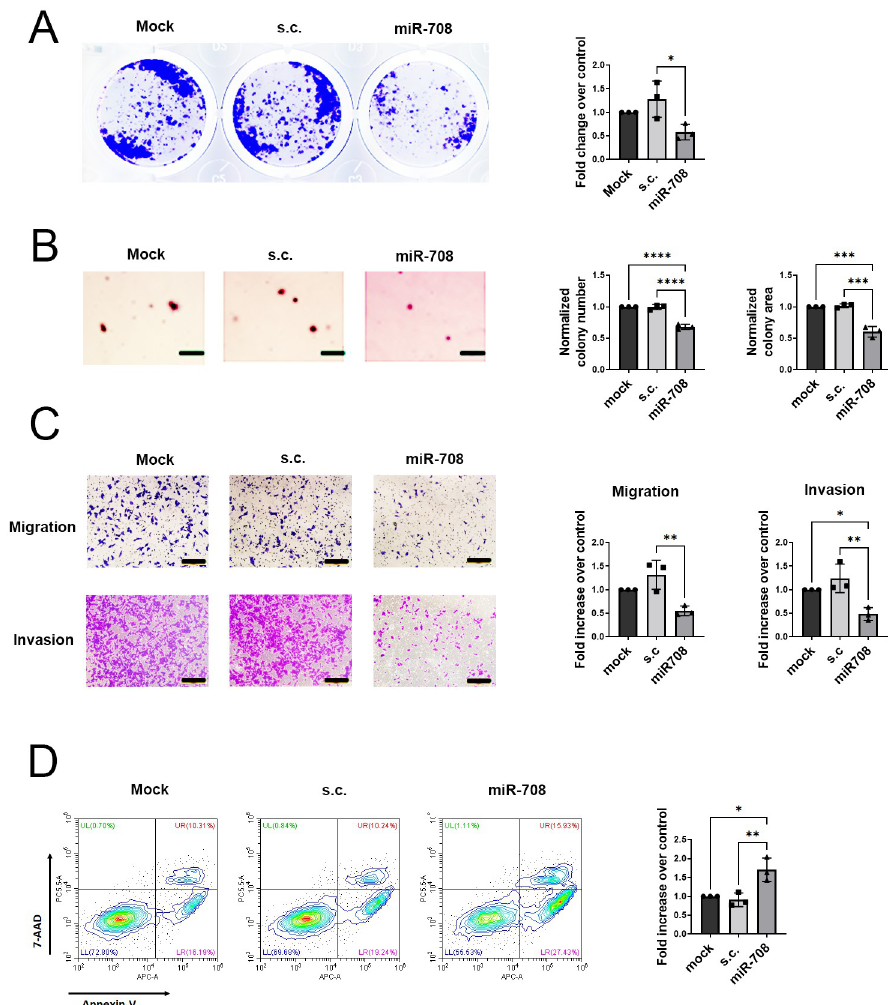
Fig 2. MicroRNA-708 inhibits proliferation, anchorage-independent growth, motility, and cell survival in NRAS- mutated cancer cells. (A) Clonogenic assay of SK-MEL-2 cells transfected with mock, s.c., and pre-miR-708. Left: representative images of SK-MEL-2 cells are shown. Right: histogram represents the fold change of mean ± SD (n = 3 biological replicates) relative to mock. (B) Soft agar colony formation assay was performed in SK-MEL-2 cells expressing mock, s.c., miR-708. Left: the representative images of SK-MEL-2. Right: the number and size of colonies were quantified and expressed as averaged fold increase compared to mock (n = 3 biological replicates). Scale bars: 200 μ m (C) SK-MEL-2 cells expressing mock, s.c., miR-708 were subjected to transwell cell migration and invasion assay. Left: the representative images of migration and invasion. Scale bars: 200 μ m. Right: the quantitative results of migration and invasion assay. Data are fold changes ± SD (n = 3 biological replicates) relative to mock. (D) Apoptosis of SK-MEL-2 cells overexpressing mock, s.c. and miR-708. Cells were incubated with 200 μ M of H 2 O 2 for 24 h and then examined by Annexin V/7-AAD staining through flow cytometry analysis. The apoptotic rate was represented by the percentage of Annexin V positive cells and then normalized with mock. Data are fold changes ± SD (n = 3 biological replicates) relative to mock. (A-D) One-way ANOVA followed by Tukey’s post-hoc test was used for all statistical tests ( * p < 0.05, ** p < 0.01, *** p < 0.001, **** p < 0.0001). and Figure S3 in S1 File), we are interested in finding out whether these miR-708-regulated cellular activities are through NRAS depletion. We used small interfering RNA (siRNA) to deplete NRAS expression and the silencing effect was validated by Western blot analysis (Fig 3A). SK-MEL-2 cells transiently transfected with siNRAS presented a lower proliferation rate and reduced anchorage-independent growth compared to control groups indicated by